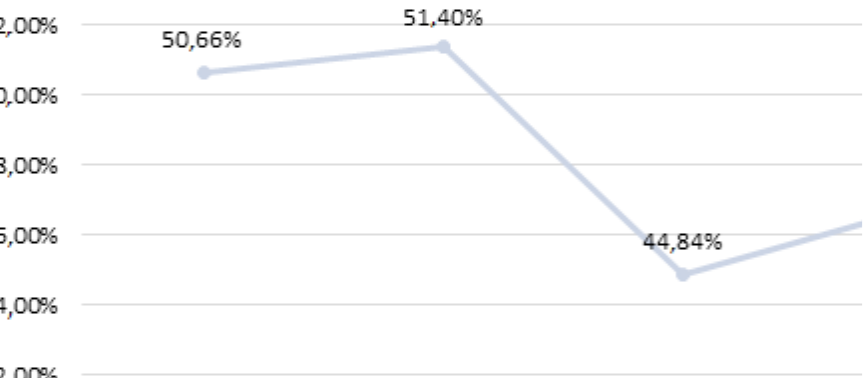
Figure 5. Working capital of SMEs financed in the MAV